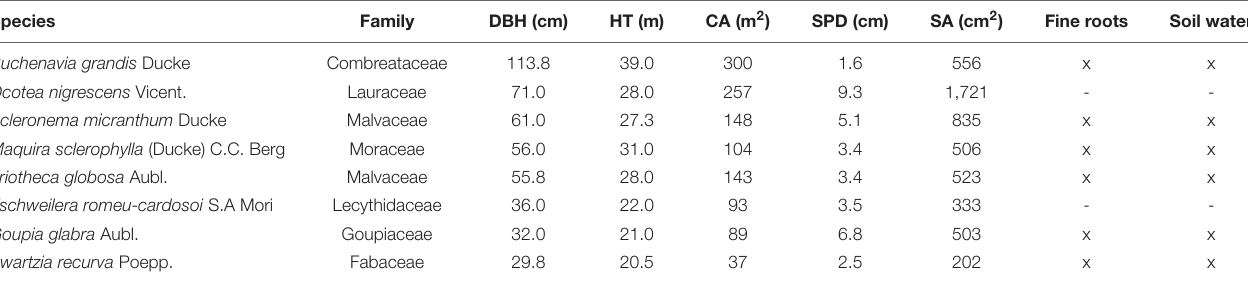
TABLE 1 | Taxonomic and biometric information of sap flow sample trees indicating diameter at breast height (DBH), height (HT), crown area (CA), dye-based sapwood depth (SPD), and sapwood area (SA) and if trees were paired with fine root biomass collections or volumetric soil water